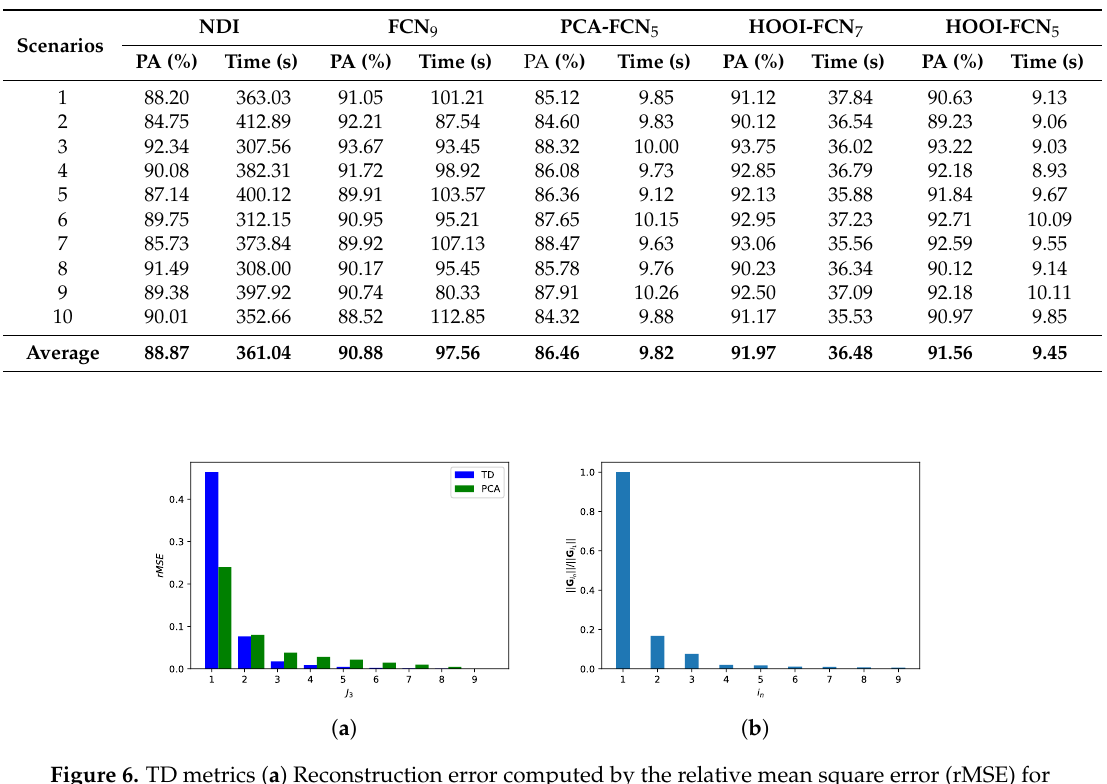
, relative to the norm of the first tensor band GGG i n